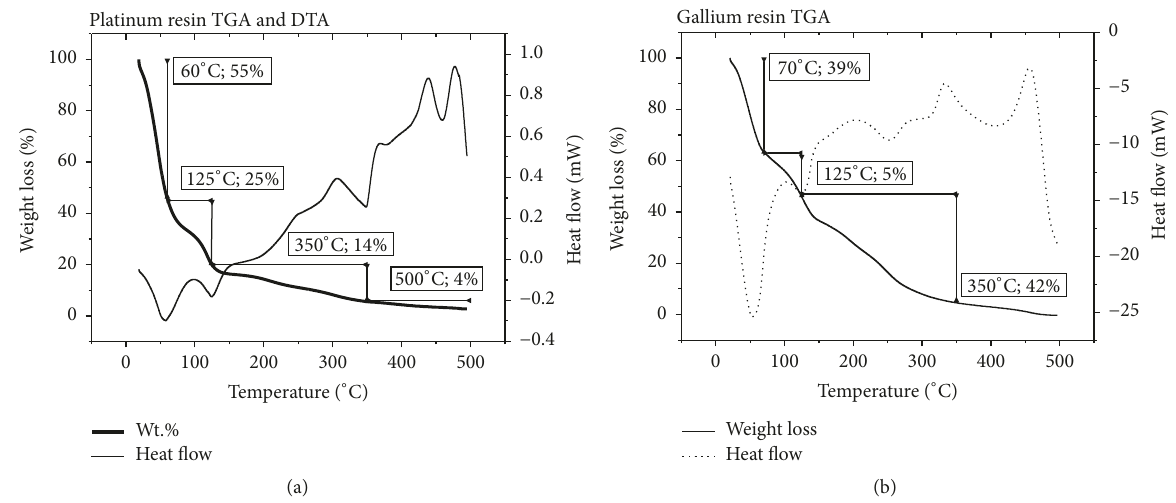
Figure 1: TGA curves obtained for (a) gallium and (b) platinum resins at heating rate of 5 ∘ Cmin −1 from room temperature to 500 ∘